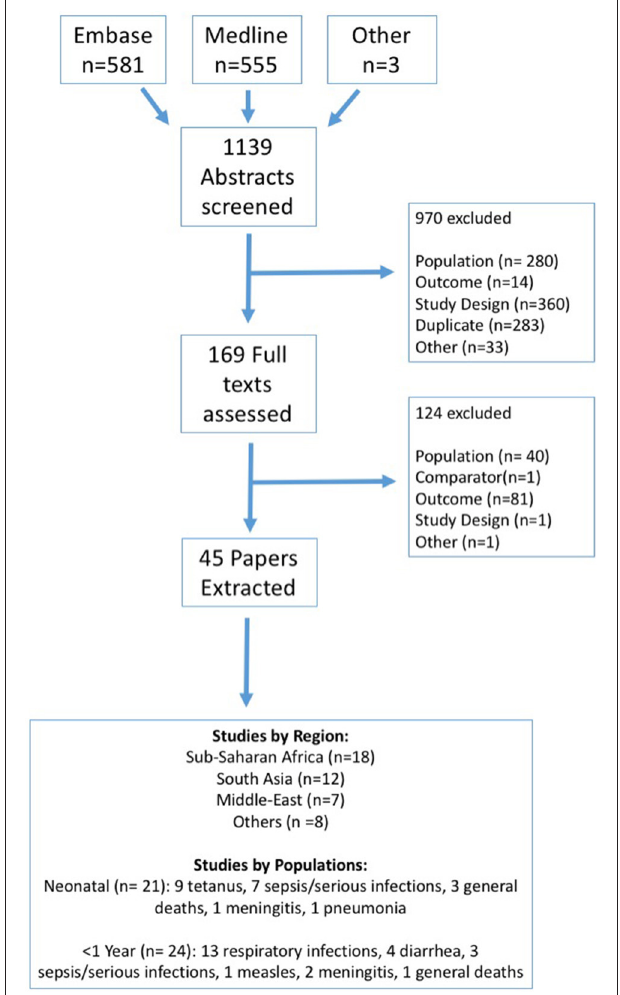
FIGURE 1 | Systematic review